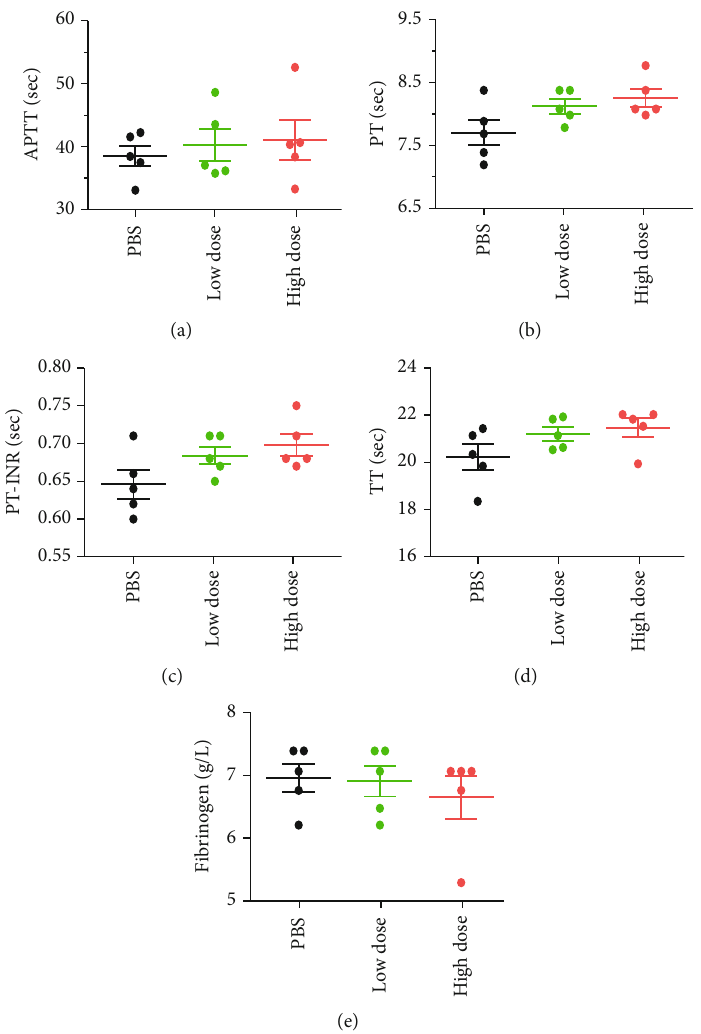
Figure 3: E ff ect of the administration of various doses of HNP-1 on the coagulation/ fi brinolysis process during sepsis progression. Wild- type mice were intraperitoneally administered a high dose of HNP-1 (10 mg/kg body weight), a low dose of HNP-1 (0.5 mg/kg body weight), or PBS 6 hours after CLP. (a – e) Routine coagulation/ fi brinolysis tests were performed 48 hours after CLP. (a) APTT. (b) PT. (c) PT-INR. (d) TT. (e) Fibrinogen. The results shown are the means ± SEMs of 5 mice in each group. APTT: prolonged activated partial thromboplastin time; PT: prothrombin time; PT-INR: prothrombin time-international normalized ratio; TT: thrombin